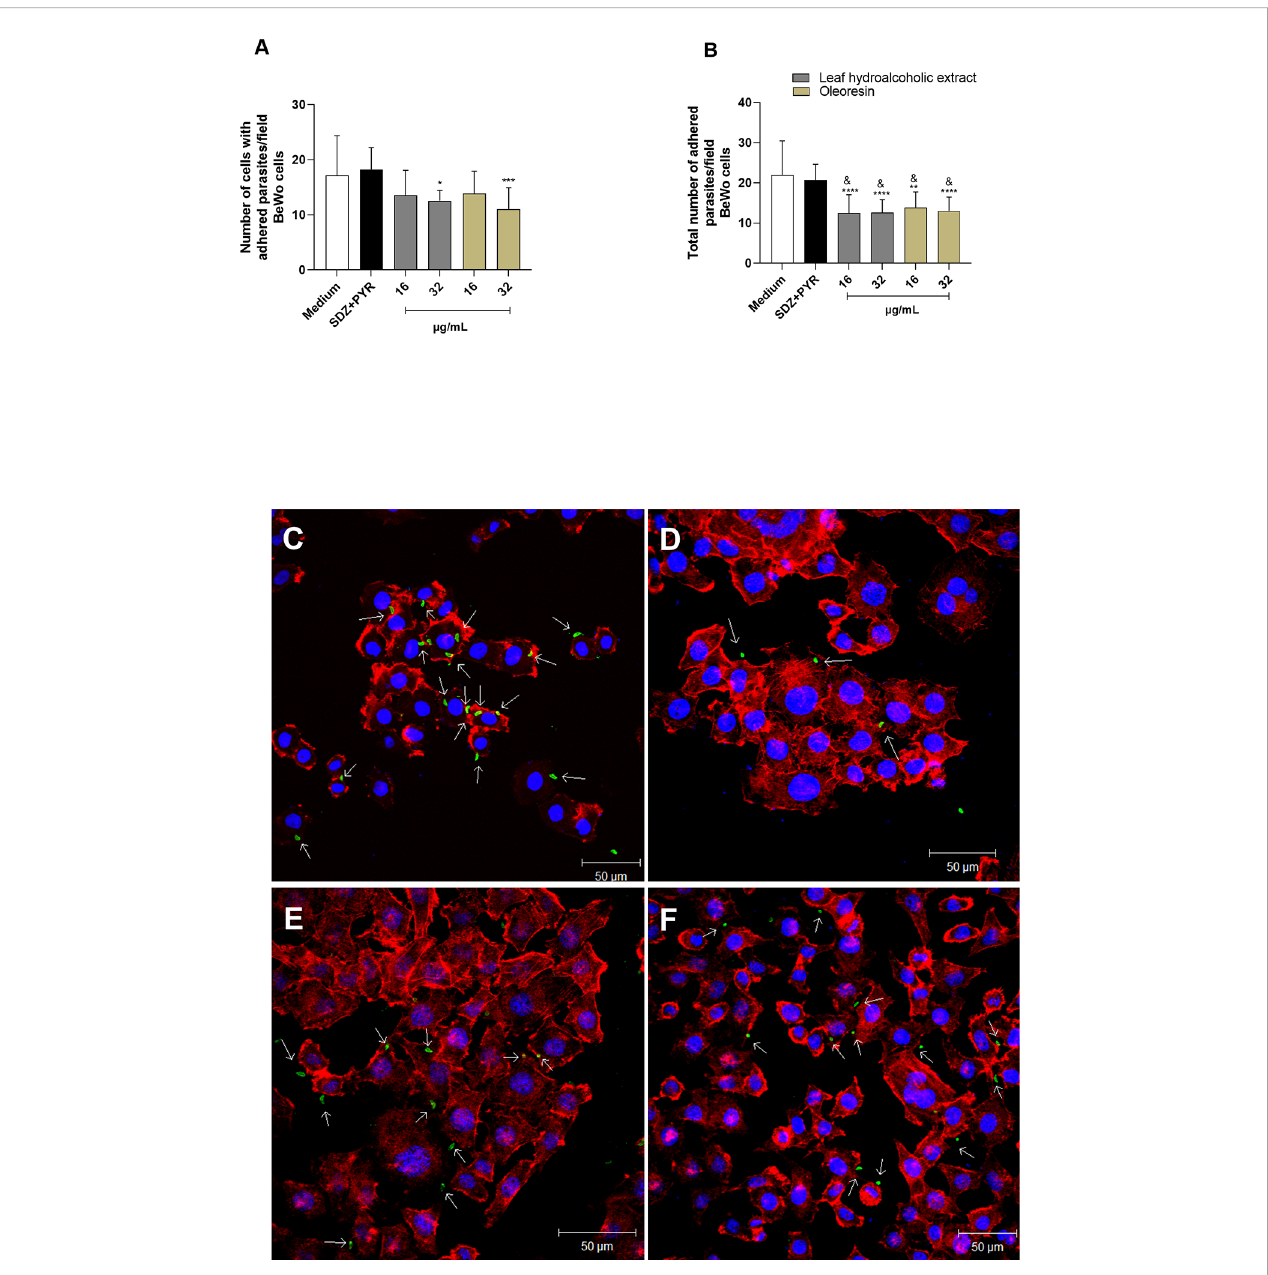
FIGURE 4 Adhesion assay in BeWo cells. T. gondii tachyzoites were preincubated for 1 h with the hydroalcoholic extract or oleoresin from C. multijuga , and then allowed to interact with previously fi xed BeWo cells during 3 h. As control, tachyzoites were incubated with SDZ + PYR or only medium (medium). The number of cells with adhered parasites (A) and the total number of adhered parasites (B) were determined in a total of 20 fi elds examined randomly with 20X objective lens. Representative images highlighting the effect of treatments on the tachyzoite-host cell interaction: (C) untreated parasites, (D) 32 µg/ mL hydroalcoholic extract, (E) 16 µg/mL oleoresin and (F) 32 µg/mL oleoresin. The results were expressed as means ± standard deviation of two experiment performed in three replicates. Signi fi cant differences detected by One-Way ANOVA and Bonferroni ’ s multiple comparisons post-test. * P < 0.05, ** P < 0.001, *** P < 0.0001 or **** P < 0.00001 in relation to the medium. & P < 0.05 in relation to SDZ + PYR. White arrows indicate tachyzoites attached to BeWo cells. The cell nucleus is labeled with TOPRO-3 (blue). T. gondii tachyzoites labeled with Alexa Fluor 488-conjugated anti-mouse IgG (green). Phalloidin-TRITC labeled F-actin is shown in red. Scale bar: 50